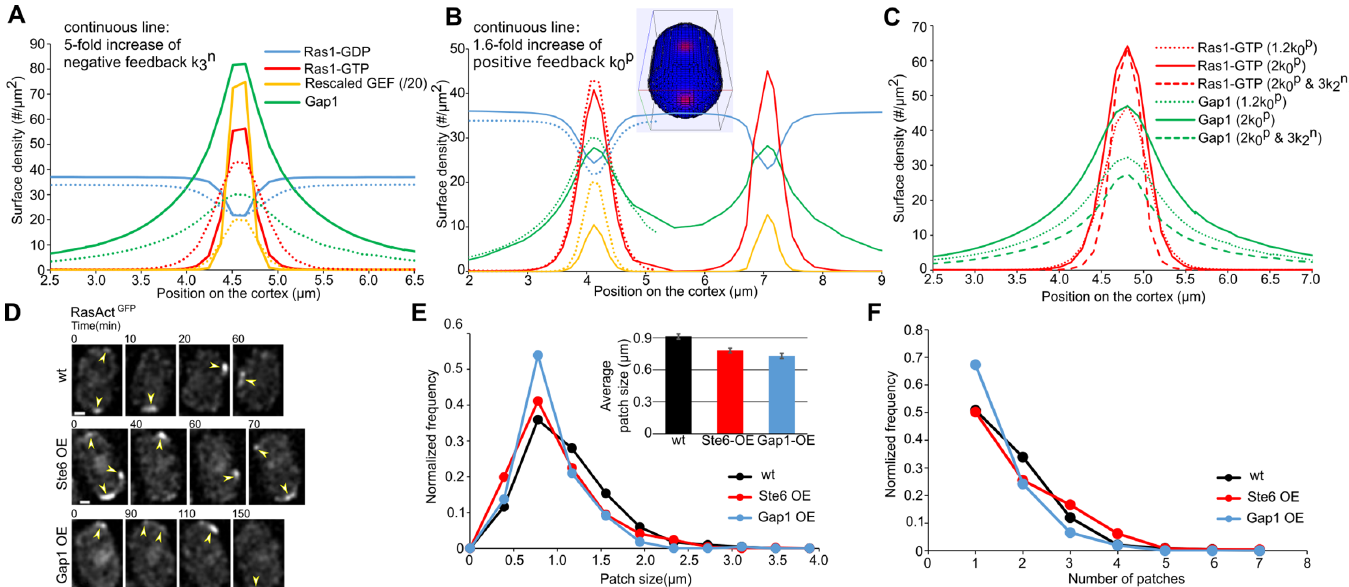
Fig 7. Regulation of a stable patch size through positive and negative feedbacks. (A) Surface density profile over a 0.2 μm wide strip along the cell long axis going through the center of an exploring patch at its peak, for overall stronger negative feedback. Solid lines: Increase of Gap1 recruitment rate constant k n by 5 times; Dotted 3 lines: Reference curves from Fig 4D (values from Table 1). (B) Surface density profile over a 0.2 μm wide strip along the cell long axis going through the center of two aligned patches peaking simultaneously, for stronger positive feedback. Solid lines: Increase of Ras1 activation rate constant k p by 1.6 times. Dotted lines: reference curves 0 from Fig 4D. (C) Surface density profile over a 0.2 μm wide strip along the cell long axis going through the center of a patch stabilized via stronger local positive feedback. Curves show effect of change with respect to values of Table 1: (i) increase of Ras1 activation rate constant k p by 1.2 times; (ii) Increase of k p by 2 times; (iii) and increase of 0 0 by 3 times, the latter over a 1.5 fold larger area than the cyan color region shown in Fig 6B. (D) Snapshots of k p 0 by 2 times and Gap1-dependent hydrolysis rate constant k n 2 RasAct GFP exploratory patch during early stages of mating in WT, Ste6 overexpression and Gap1 overexpression cells also expressing Myo52-tdTomato. The scale bar is 1 μm. Shown examples are not necessarily consecutively observed patches. (E) Patch size in WT ( n = 404 patches in 23 cells), Ste6 overexpression ( n = 467 patches in 28 cells) and Gap1 overexpression cells ( n = 219 patches in 24 cells). Inset shows the average patch size and standard error calculated for WT ( 0 : 91 (cid:6) 0 : 02 m m ), Ste6 overexpression ( 0 : 78 (cid:6) 0 : 02 m m ) and Gap1 overexpression cells ( 0 : 73 (cid:6) 0 : 02 m m ). The two sample t-test between WT and the mutants shows mean patch sizes are different at 0.01 significance level. (F) Normalized frequency of observed simultaneous patches in WT, Ste6 overexpression and Gap1 overexpression cells. We note that the patch intensity decreases in Gap1 overexpression cells (S6A Fig) while our threshold for patch detection is the same as wt cells; thus we cannot exclude the possibility of more patches in Gap1 overexpression cells below the detection threshold.